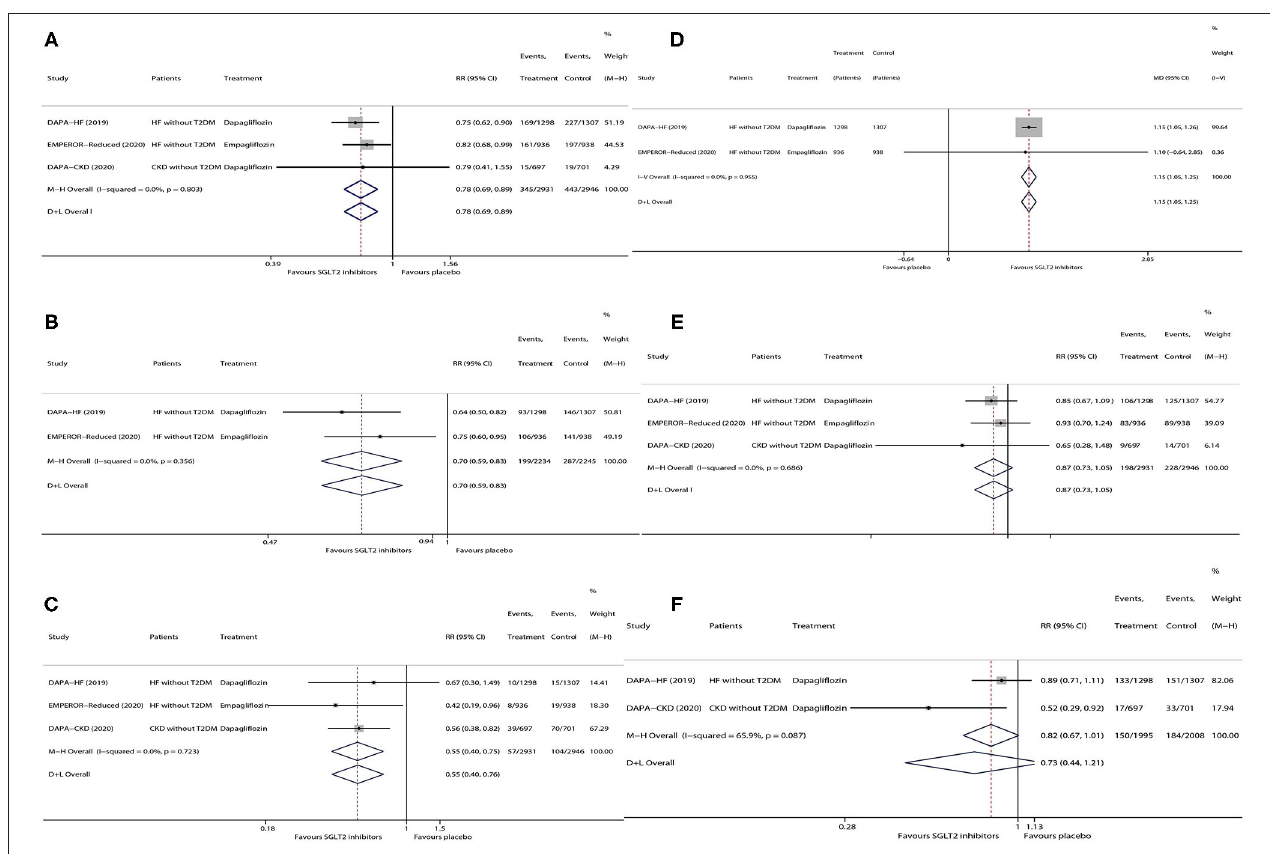
FIGURE 1 | Meta-analysis of the effects of SGLT2 inhibitors on HHF or CVD (A) , HHF (B) , KSCO (C) , change in KCCQ total score (D) , CVD (E) , and ACM (F) in patients without T2DM. SGLT2, sodium-glucose cotransporter 2; HHF, hospitalization for heart failure; CVD, cardiovascular death; KSCO, kidney-specific composite outcome; KCCQ, Kansas City Cardiomyopathy Questionnaire; ACM, all-cause mortality; HF, heart failure; T2DM, type 2 diabetes mellitus; CKD, chronic kidney disease; MD, mean difference; RR, risk ratio; CI, confidence